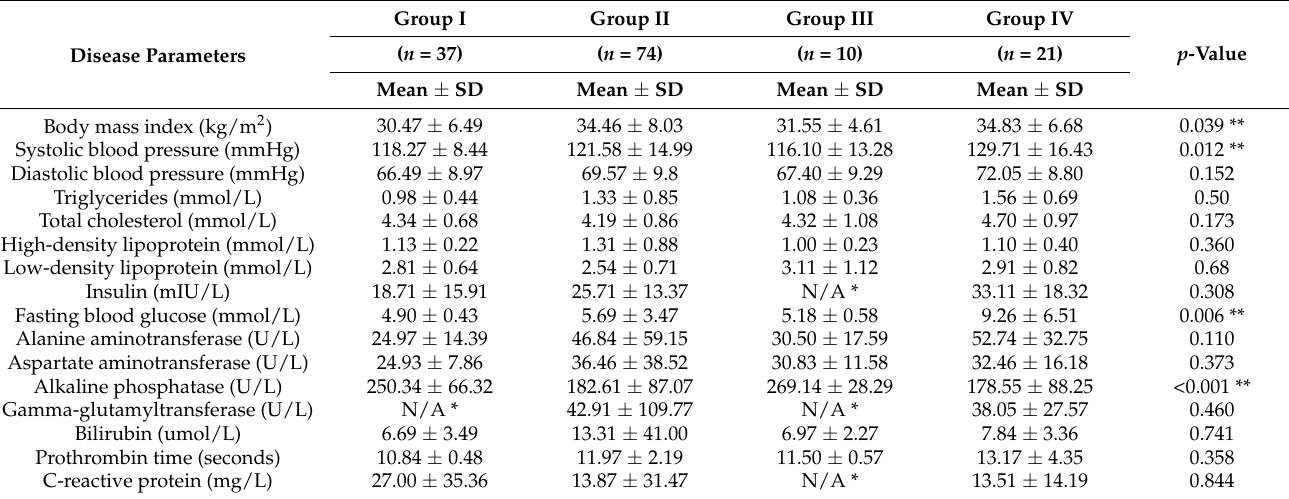
Table 3. Baseline characteristics of the subjects among the four